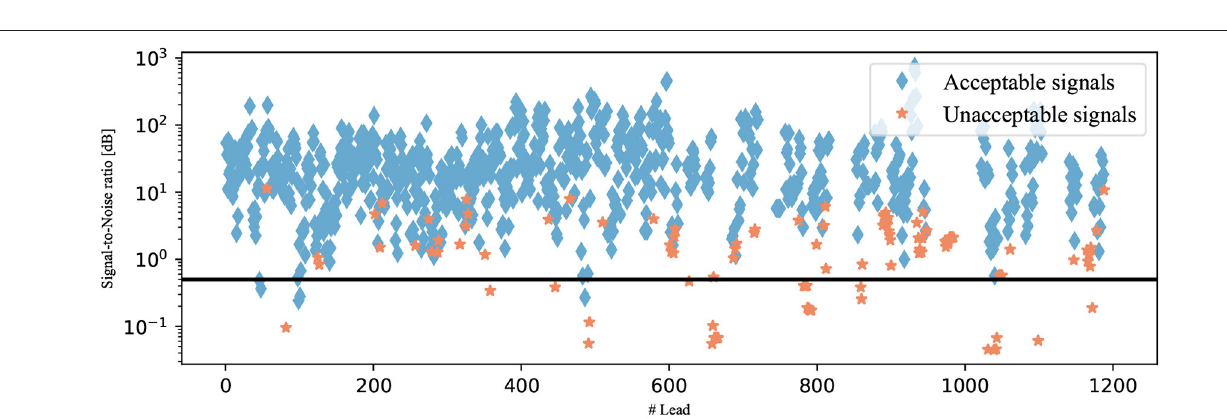
criteria were used for the quality analysis. In contrast, in Algorithm III, the data from the training data set influenced the